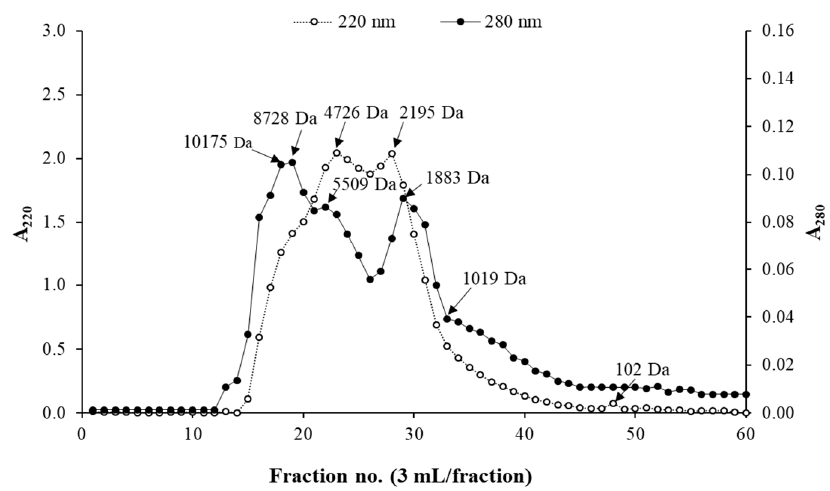
Figure 1. Elution profiles of defatted hydrolyzed collagen (HC) from salmon skin using SephadexTM G-25 gel filtration chromatography.